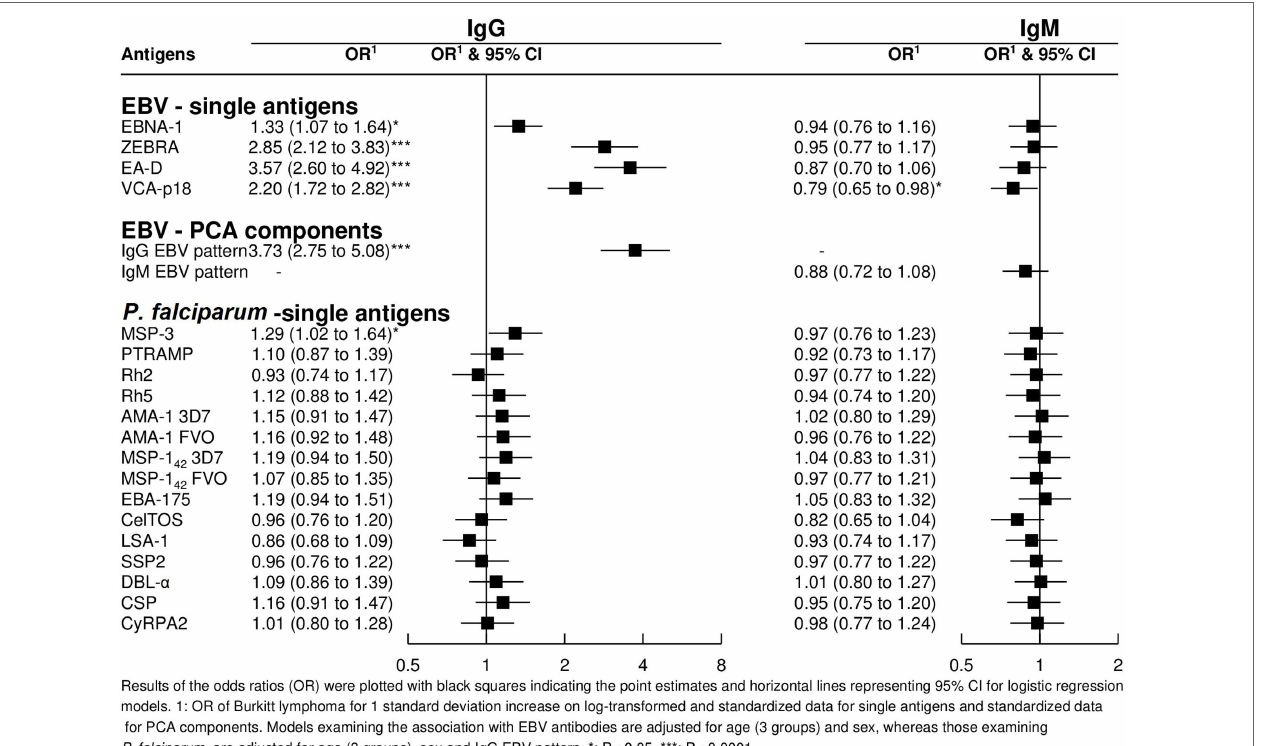
FigUre 3 | Odds ratios (ORs) for endemic Burkitt lymphoma in relation to IgG and IgM levels against single Epstein–Barr virus (EBV) and Plasmodium falciparum antigens and against EBV PCA